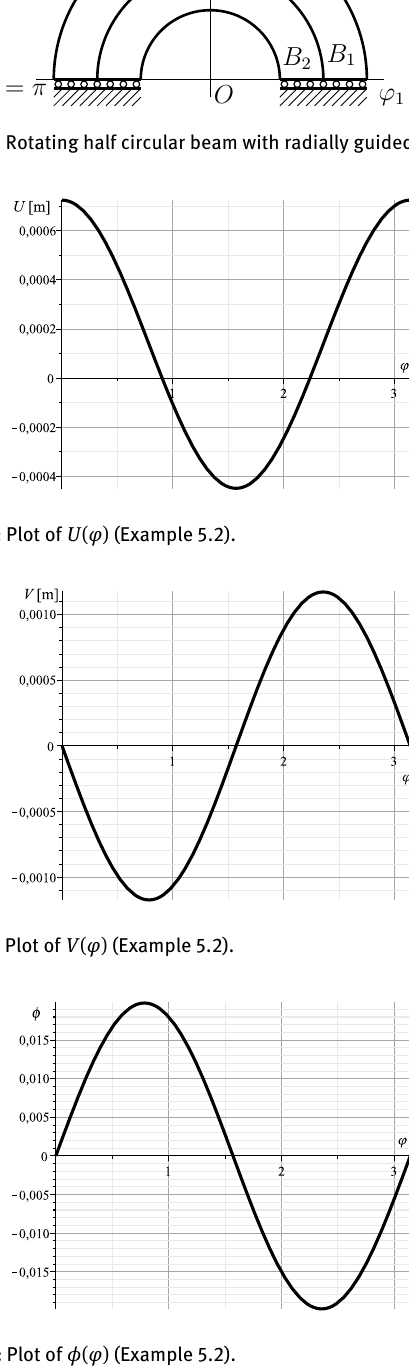
Figure 16: Plot of ϕ ( φ ) (Example